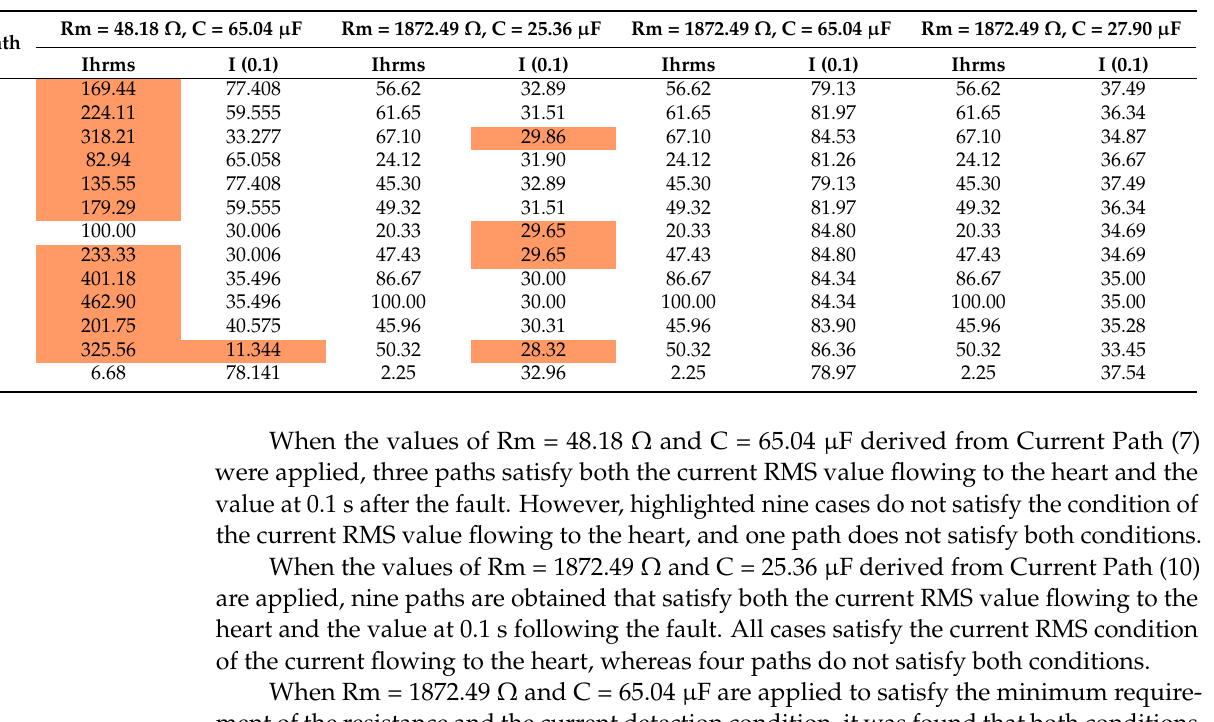
Table 8. Current RMS value flowing to the heart and the discharging current value at 0.1 s after the fault based on the resistance and capacitance derived from Table